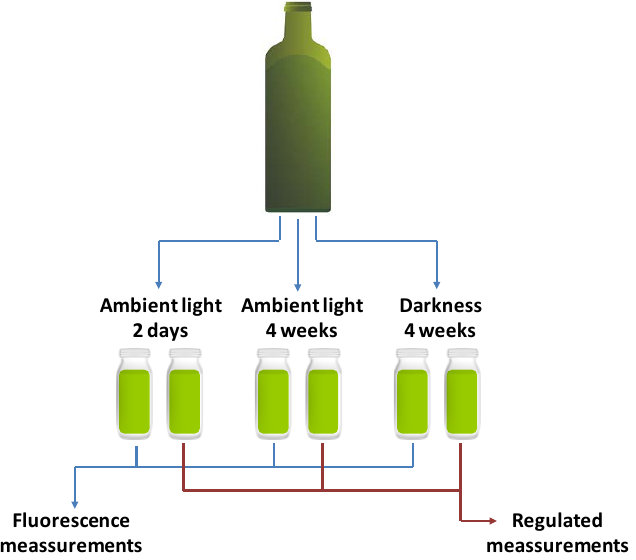
Figure 1. Illustration of light exposure treatments and measurements carried out on each replicate.